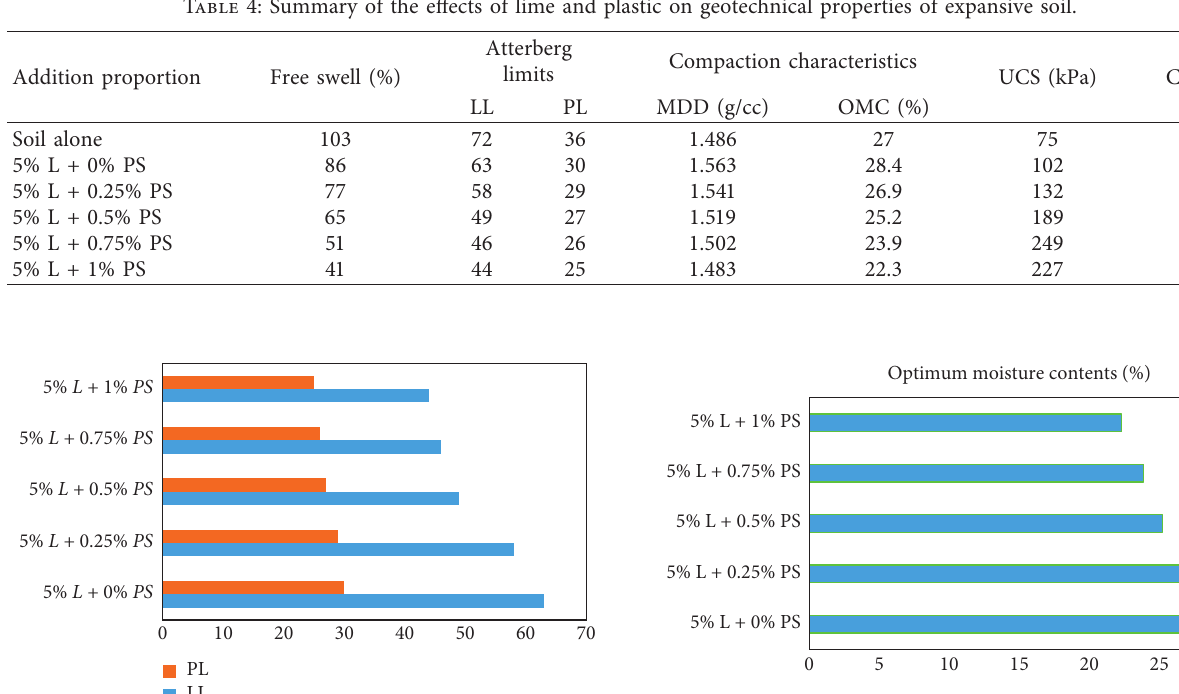
Figure 4: Variation of optimum moisture content with plastic strips.